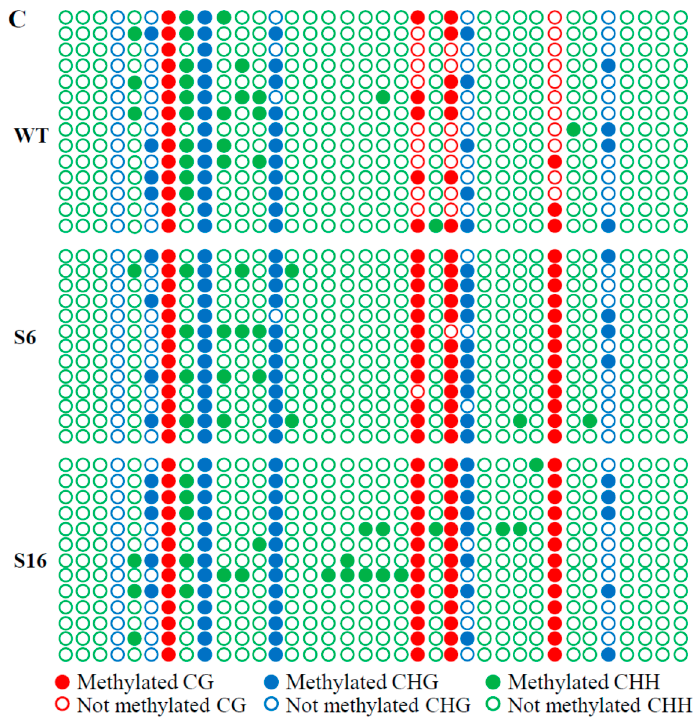
Figure 9. The DNA methylation of OsPKS2 gene promoter in young panicles. ( A ) The diagram of bisulfite sequencing of 221 bp OsPKS2 promoter. ( B ) The statistics of bisulfite sequencing of 221 bp OsPKS2 promoter in WT and osros1a mutants. ( C ) The dot plot comparison of DNA methylation between WT and osros1a mutants.